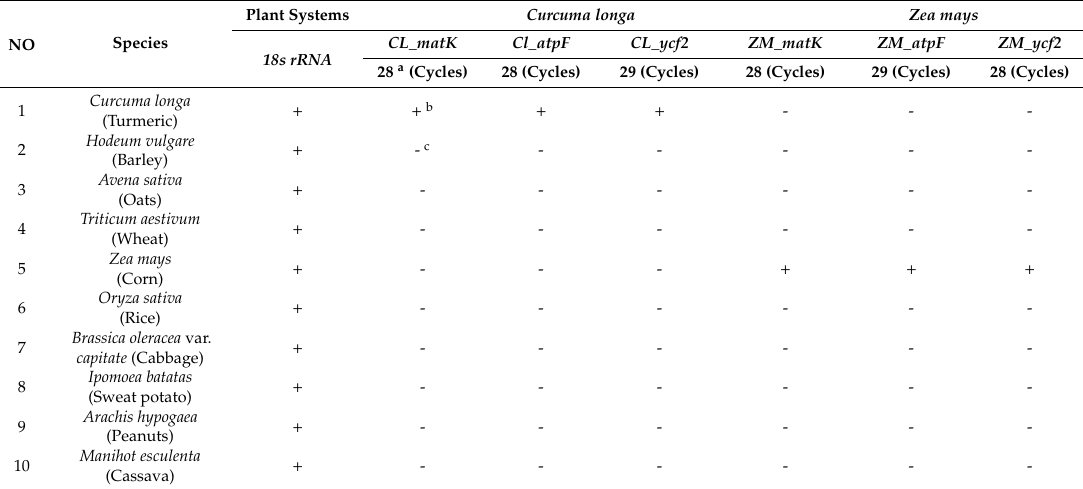
Table 2. Results of the specificity test with other